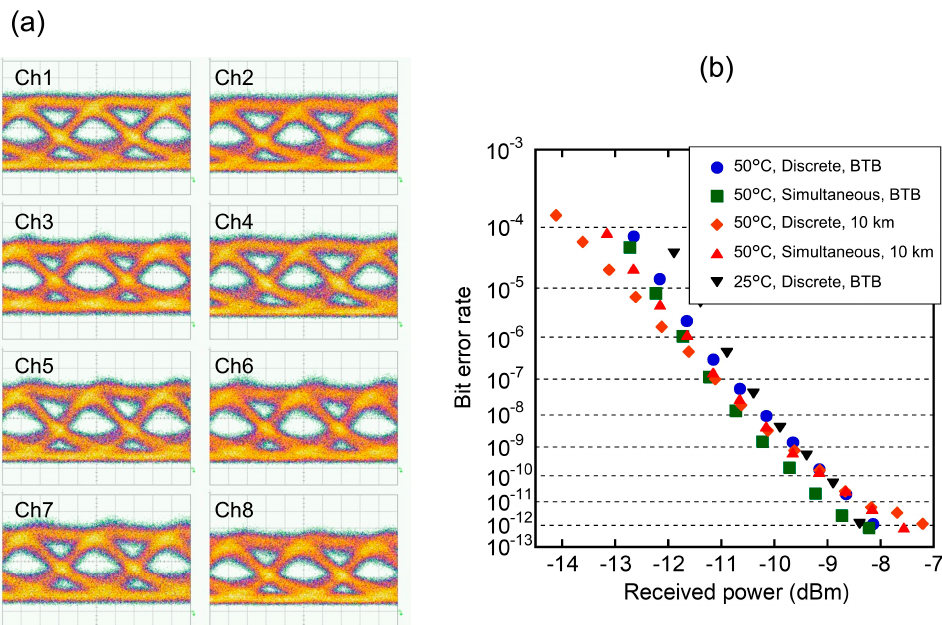
Figure 11. ( a ) Eye diagrams for directly modulated lasers (DMLs) with 25.8 ‐ Gbit/s non ‐ return ‐ to ‐ zero (NRZ) signals at 50 °C; ( b ) bit ‐ error ‐ rates (BER) characteristics of back ‐ to ‐ back (BTB) and after 10 ‐ km transmissions at 50 °C.